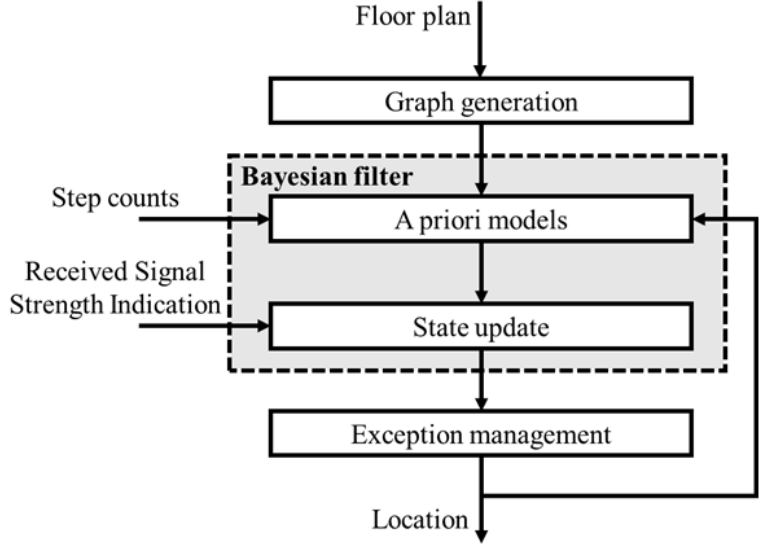
Figure 3. A schematic representation of how the localization algorithm was derived.